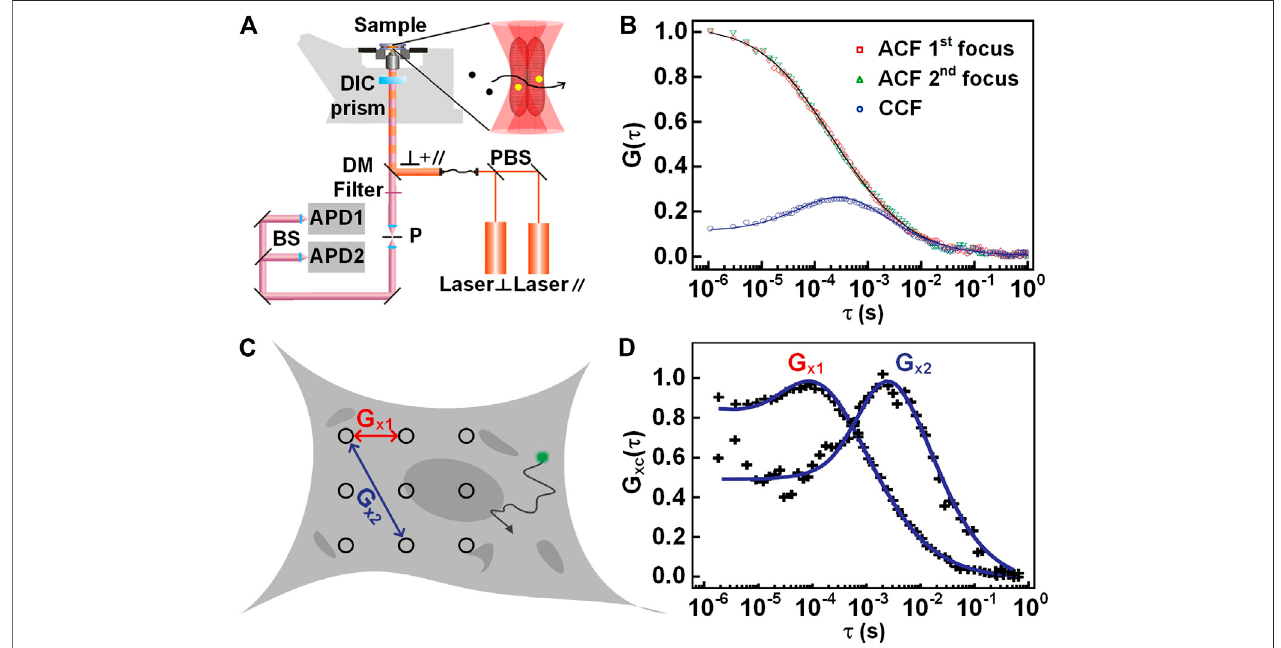
FIGURE 3 | Illustration of dual-focus and multi-focus FCS. ( A ) Schematic setup of dual-focus FCS. ( B ) Autocorrelation and cross-correlation curves of dual-focus FCS. ( C ) Schematic view of multi-focus FCS measurement. ( D ) The correlation curves between two pairs of positions with different distances. Adapted from Refs. [11,